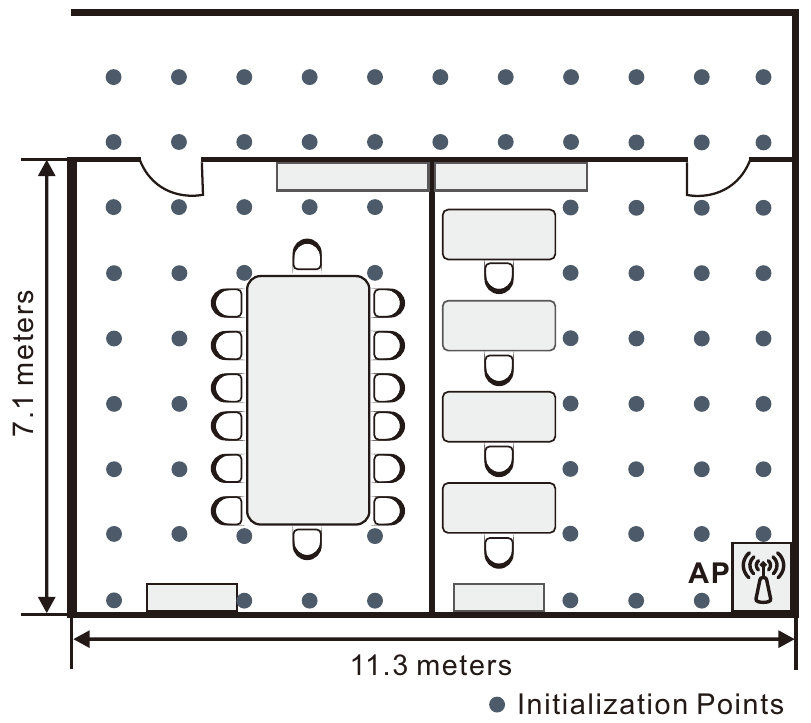
Figure 6. Layout and database points for the two office rooms. The AP is placed at the lower-right corner of the right room.